Question: Express in one sentence what the figure is showing.
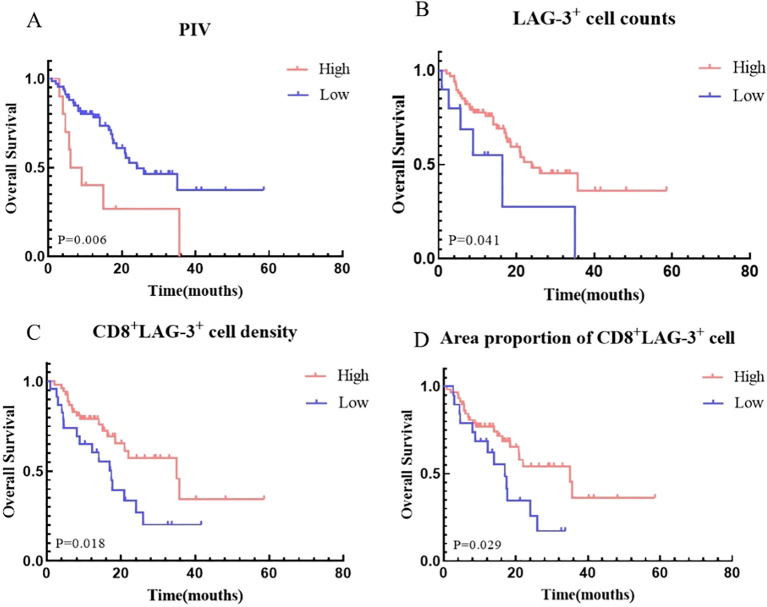
Answer: Kaplan-Meier survival curves for different peripheral blood levels and cell subset rates in patients. (A) OS curves for PIV; (B) OS curves for LAG-3 + cell counts; (C) OS curves for CD8 + LAG-3 + cell density; (D) OS curves for area proportion of CD8 + LAG-3 + cell.